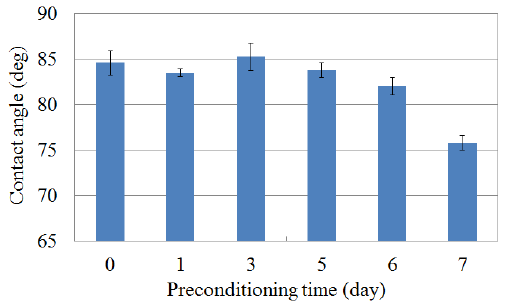
Figure 6. Relationship between the contact angle of the membrane surface and the preconditioning time. Data are expressed as mean ± SD (n = 3).